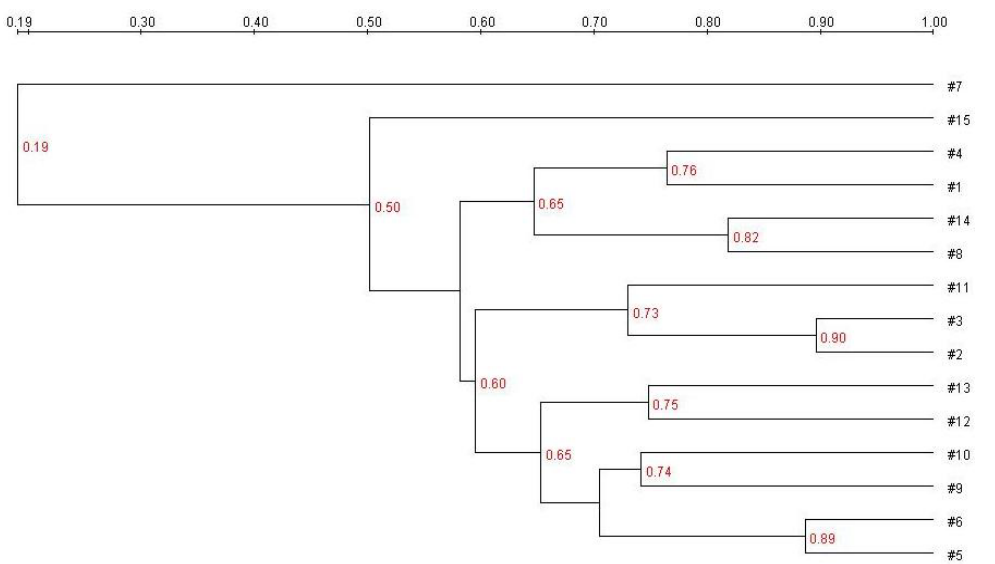
Figure 3. Cluster analysis using the unweighted pair group method with arithmetic mean (UPGMA) method based on the Dice coefficient for the band pattern in Figure